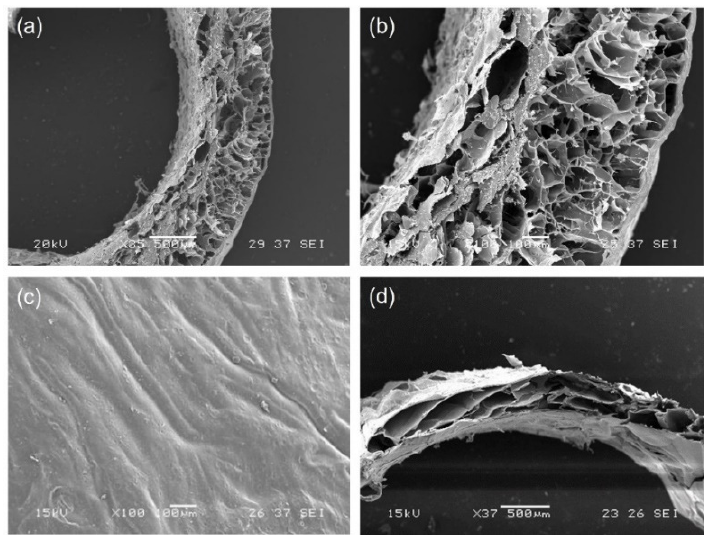
Figure 2. SEM micrographs of: ( a , b ) section and ( c ) external surface of untreated GGE tubular scaffold; ( d ) section of cross-linked GGE tubular scaffold.